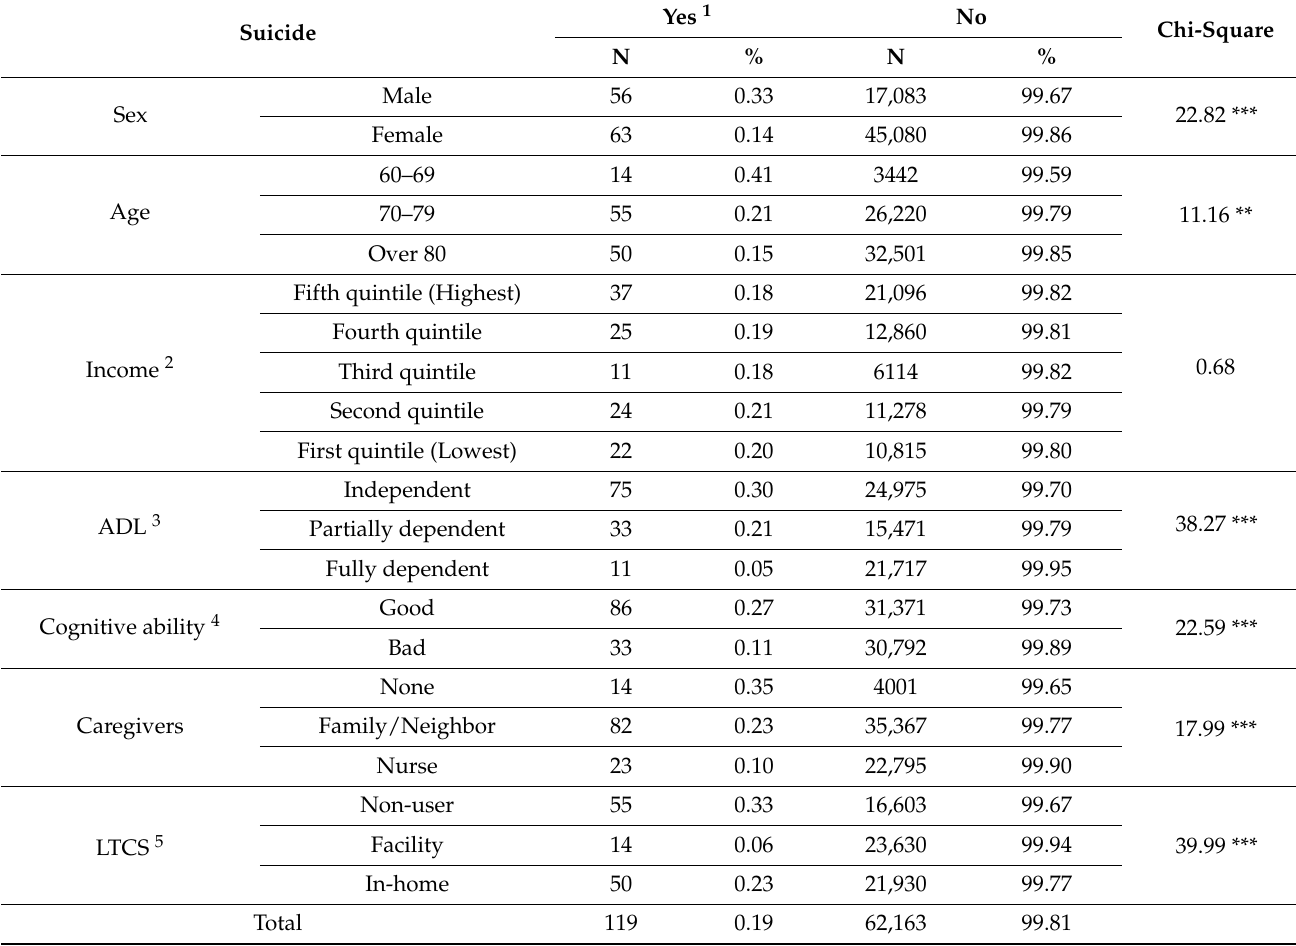
Table 1. Suicide frequency by general characteristics of the elderly with